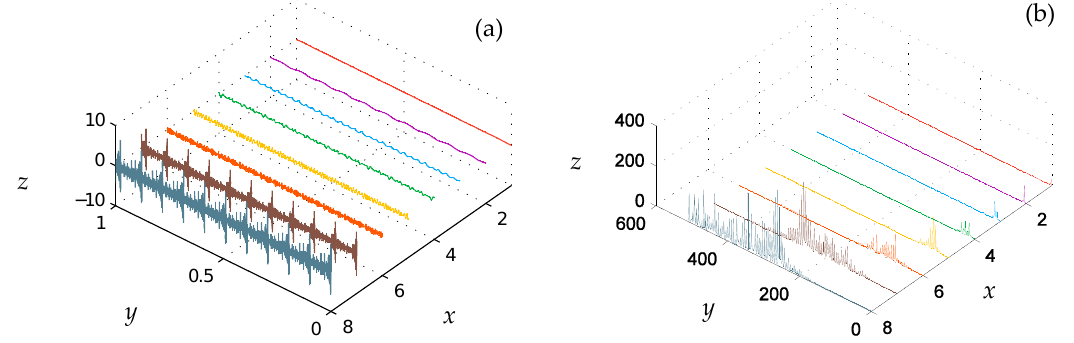
Figure 8. Simulation signal DTCWT component of ( a ) the time domain and ( b ) the frequency domain. Each x axis tick in the figure means a DTCWT component where blue grey line indicates the w 1 ( t ), the brown line indicates the w 2 ( t ), the orange line indicates the w 3 ( t ), the yellow line indicates the w 4 ( t ), the green line indicates the w 5 ( t ), the blue line indicates the w 6 ( t ), purple line indicates the w 7 ( t ) and the red line indicates the c 7 ( t ) .